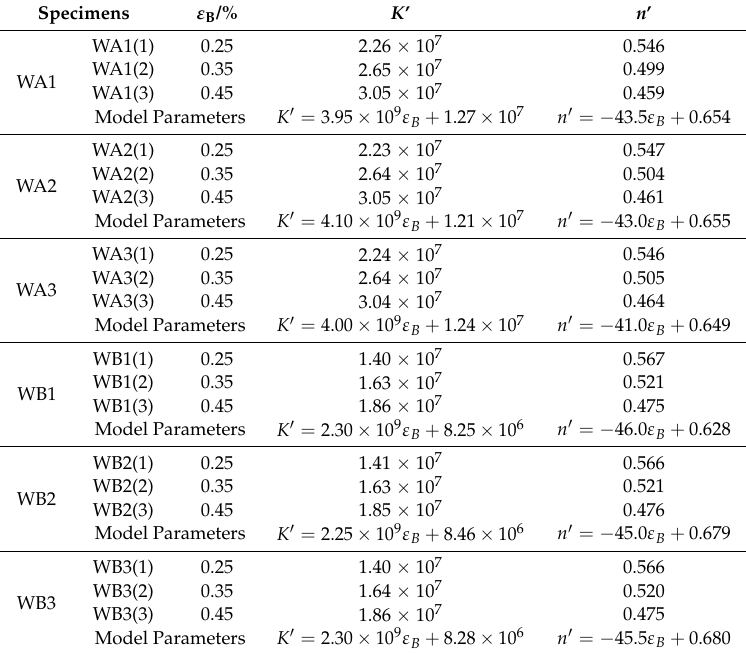
Table 9. Values of parameters K ’ and n ’.